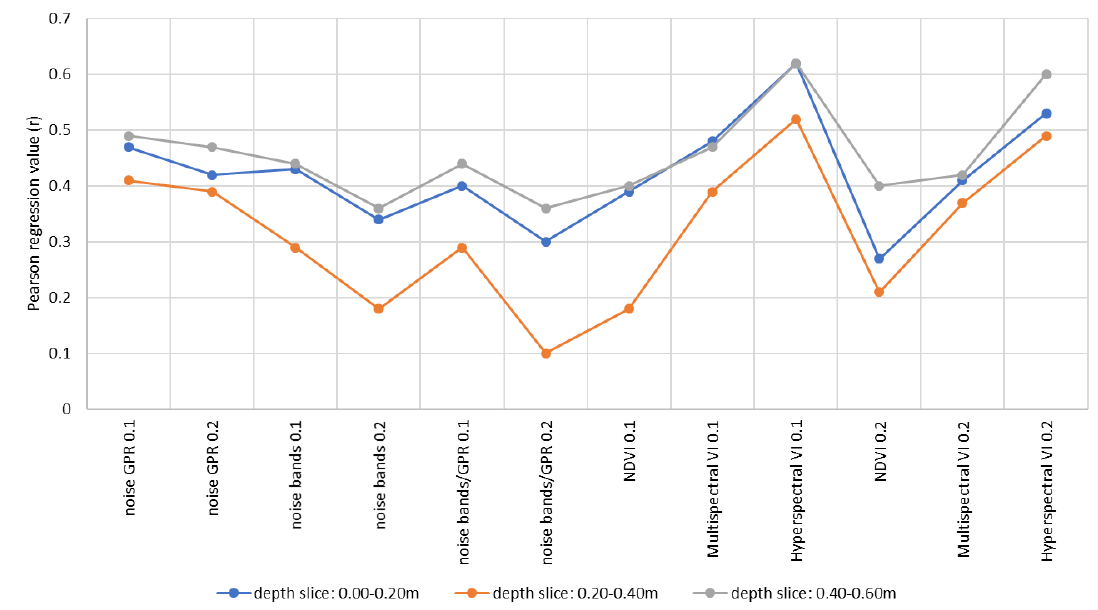
Figure 11. Regression value r for all different types of combination of fusion between the optical (spectroradiometric) and GPR datasets with the noise of levels 0.1 and 0.2 for all depth slices.